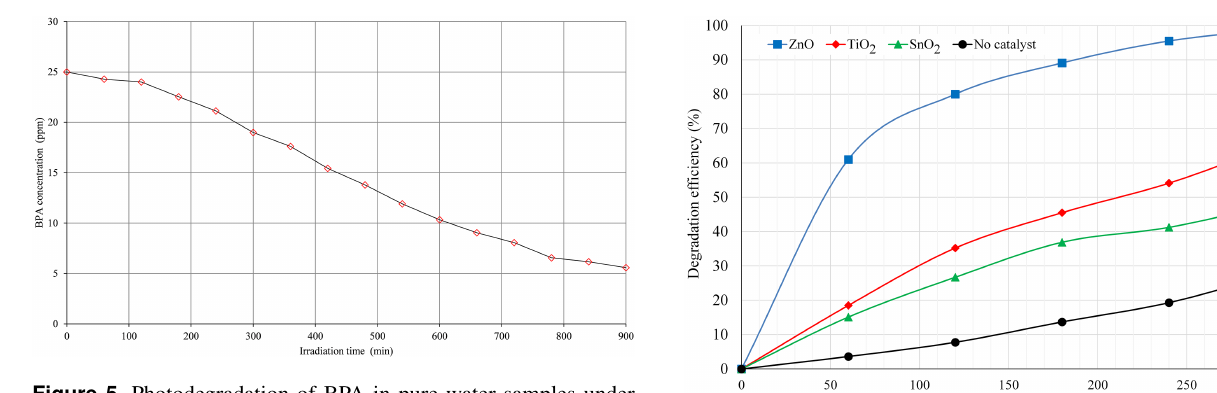
Figure 5. Photodegradation of BPA in pure water samples under low-intensity UV irradiation.